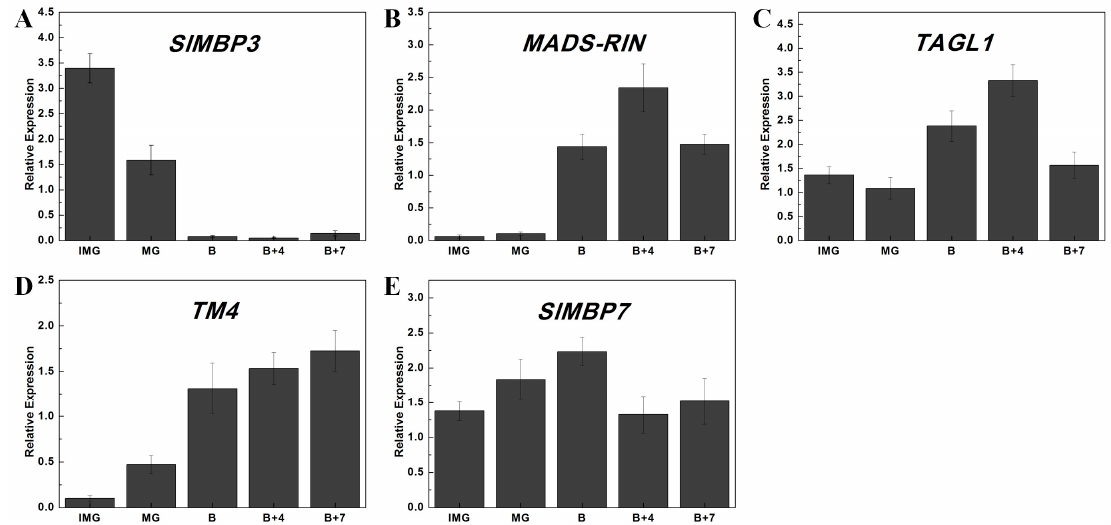
Figure 6. Relative expression of tomato MADS-box genes in di ff erence stages of fruit development and ripening by qPCR analysis. Expression patterns of SlMBP3 ( A ), MADS-RIN ( B ), TAGL1 ( C ), TM4 ( D ), and SlMBP7 ( E ) in di ff erent organs, including mature green (MG), break (B), four days after break (B + 4), and seven days after break (B + 7). Each value represents the mean ± SE of three technical replicates of a single biological sample. The SlCAC gene of tomato was used as the internal standard.